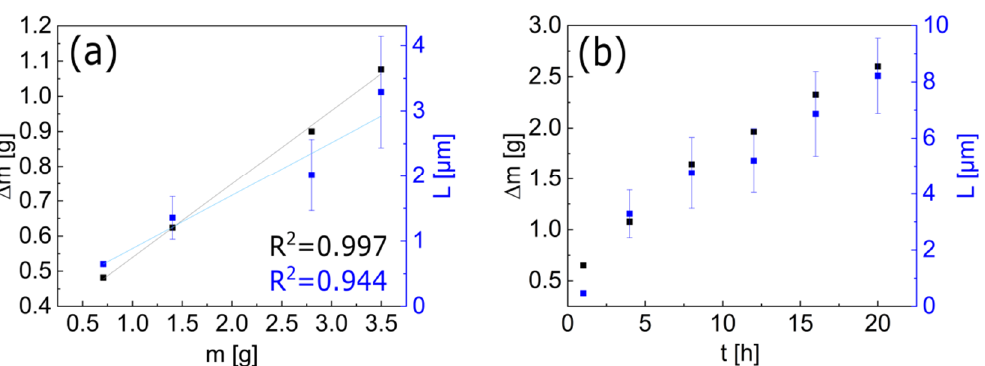
Figure 6. Correlations between the used and consumed amount of zinc precursor, the growth time, and the nanowhiskers’ lengths. ( a ) The zinc precursor consumption is proportional to the used amount of precursor at 4 h growth leading to a precursor usage of 0.210 ± 0.007 g/g of employed precursor (black squares). Also, the length of the nanowhiskers is proportional to the used precursor amount within a 4 h growth process with a factor of 0.815 ± 0.114 µm/g (blue squares). ( b ) The precursor consumption (black squares), as well as the whiskers’ lengths (blue squares), show a non-linear dependence on the growth time when using a precursor amount of 3.5 g.